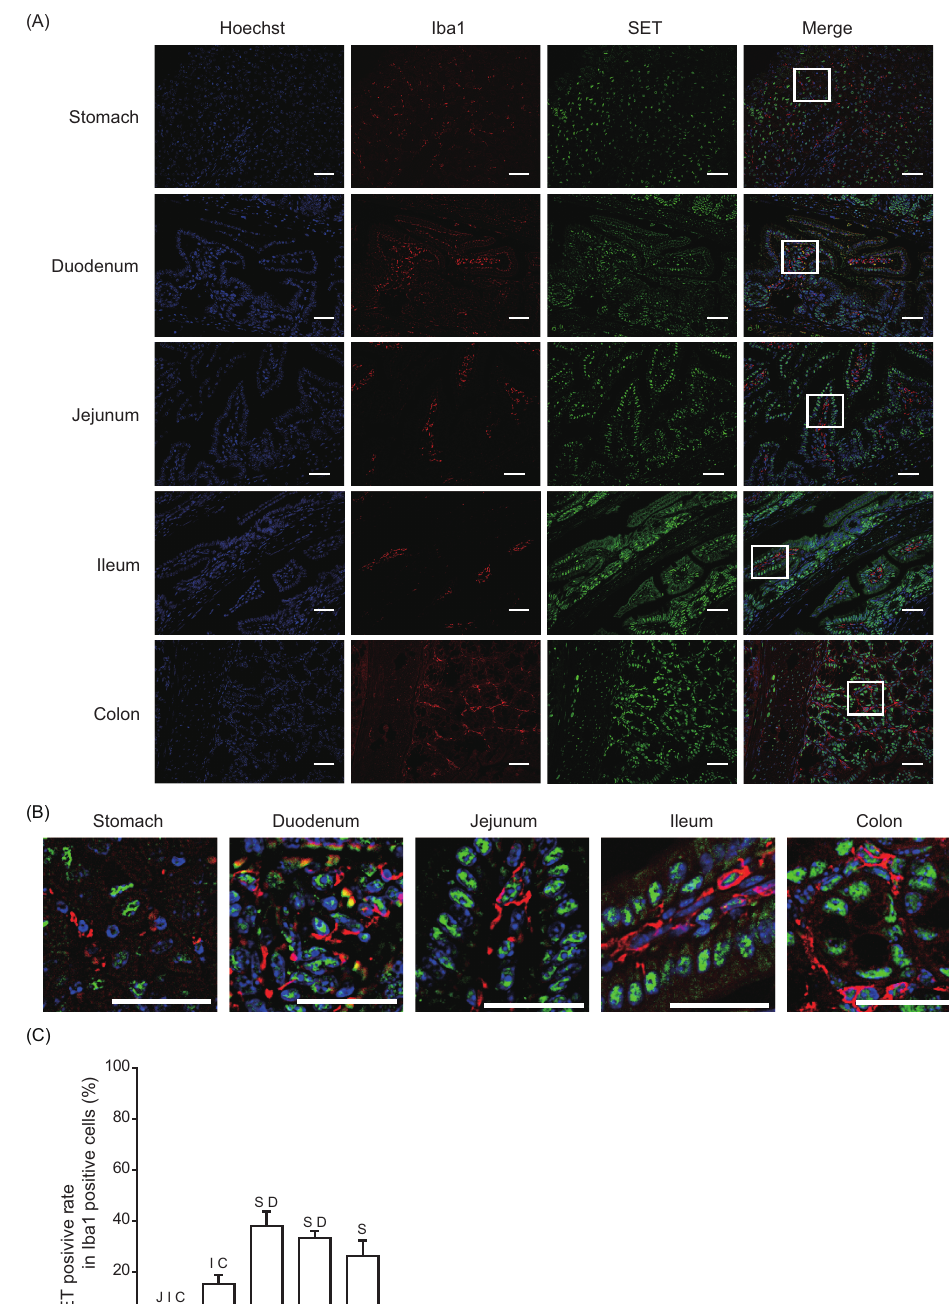
Fig 3. SET-positive rate in monocytes/macrophages. Immunofluorescence staining was performed to analyze SET and Iba1 expression in gastrointestinal tissues from mice. (A, B) Representative pictures of SET (Green), Iba1 (Red), Hoechist 33342 (Blue), and merge are shown. Enlarged pictures of indicated area in (A) are shown in (B). Scale bars: 40 μ m. (C) Quantitative data (means ± S.E.) for SET positive rate in Iba1 positive cells are shown. N = 3. S: p < 0.05 vs. Stomach, D: p < 0.05 vs. Duodenum, J: p < 0.05 vs. Jejunum, I: p < 0.05 vs. Ileum, C: p < 0.05 vs.